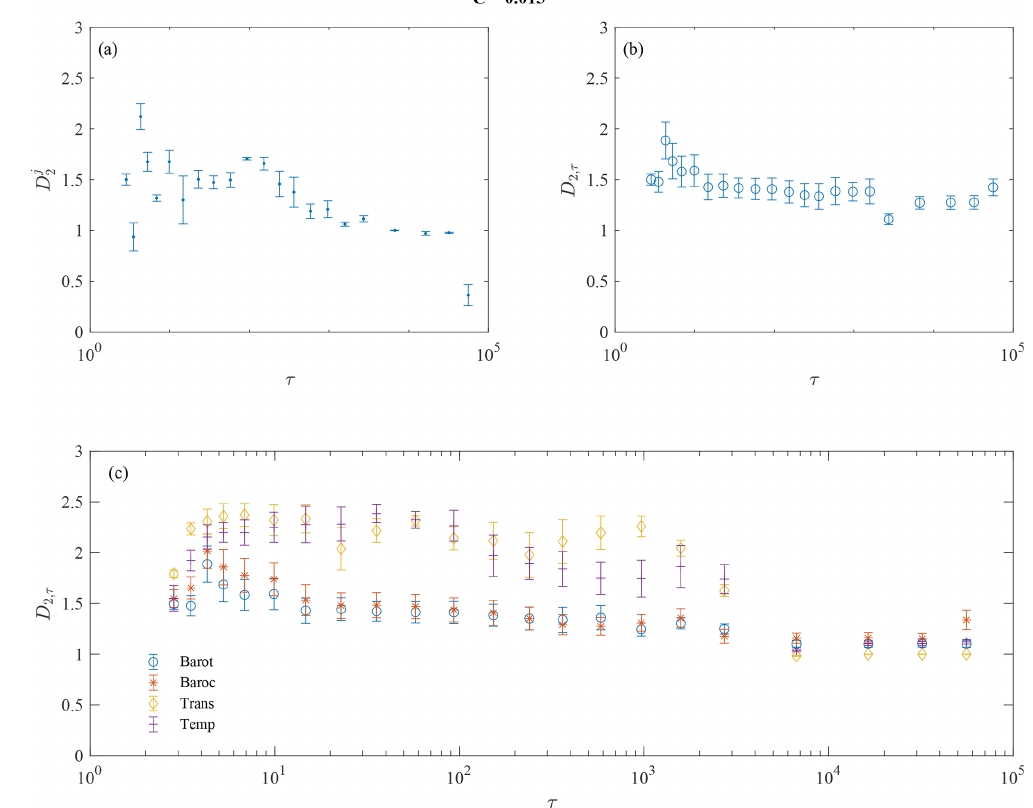
Figure 6. Same as in Fig. 5, but for C = 0 .